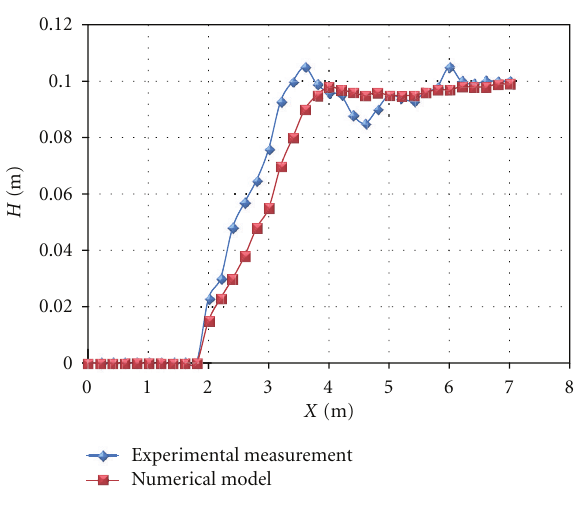
Figure 7: O ff shore wave height distribution.